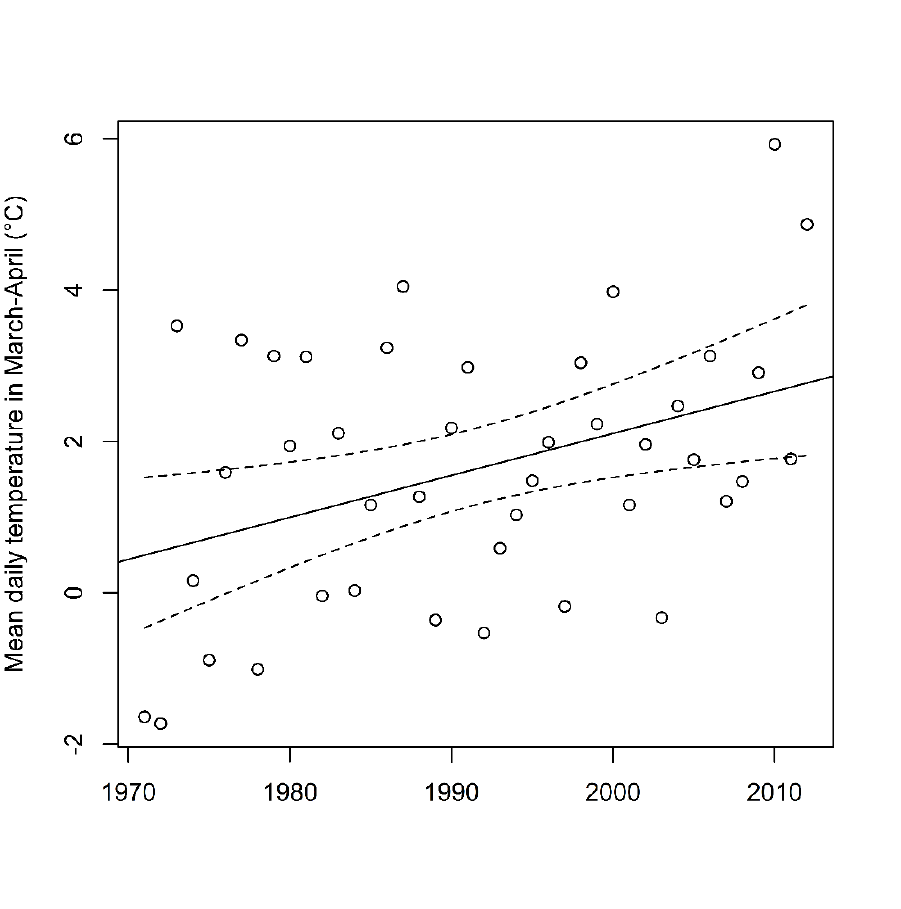
Fig. A1.1. Mean daily temperature in March-April recorded at five stations in southern Quebec (Dorval, Joliette, Lachute, Sainte-Martine, Saint-Hubert, Saint-Jérôme), 1971- 2012. The solid line represents the regression function while the dashed lines represent the 95% confidence